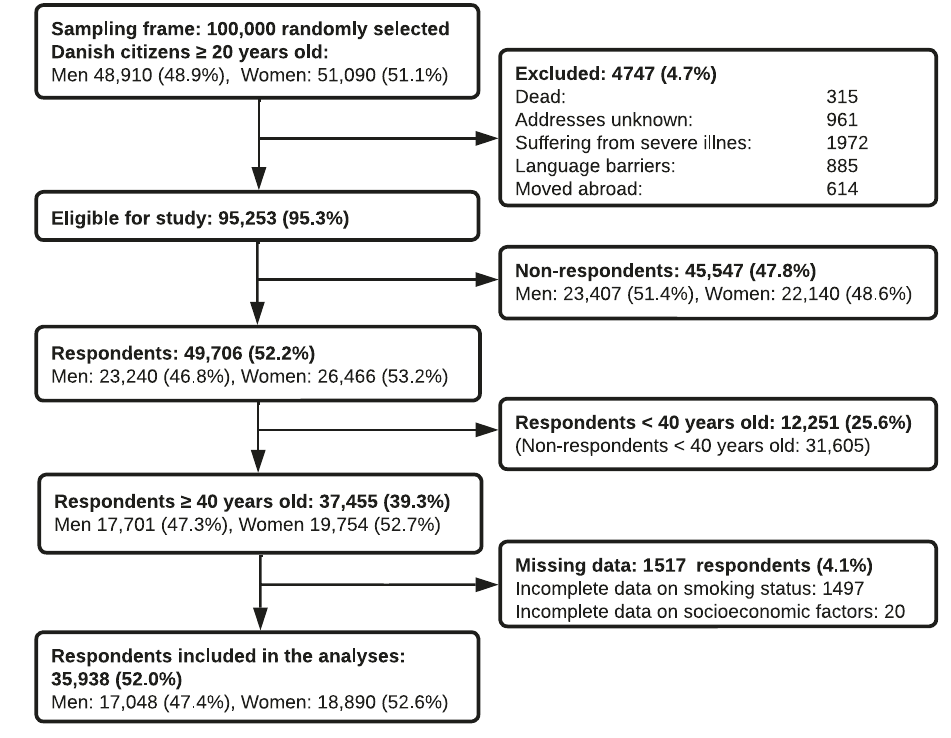
Fig. 1 Flowchart. Flowchart of the study sample selection